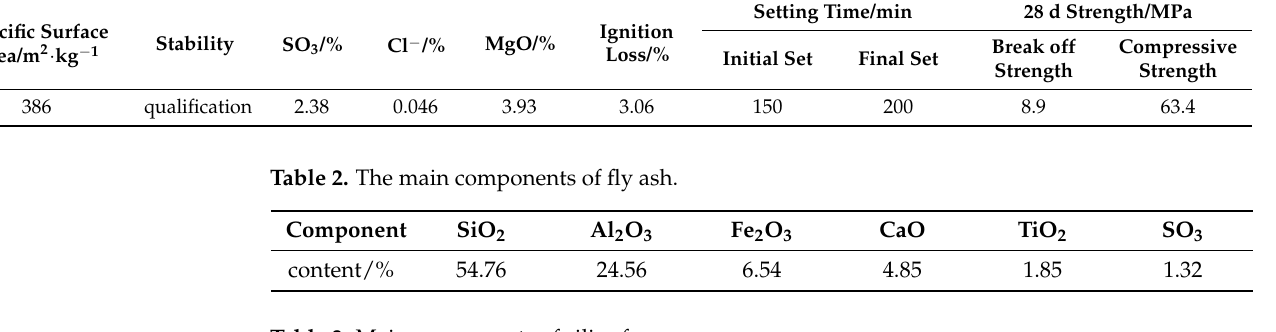
Table 3. Main components of silica fume.